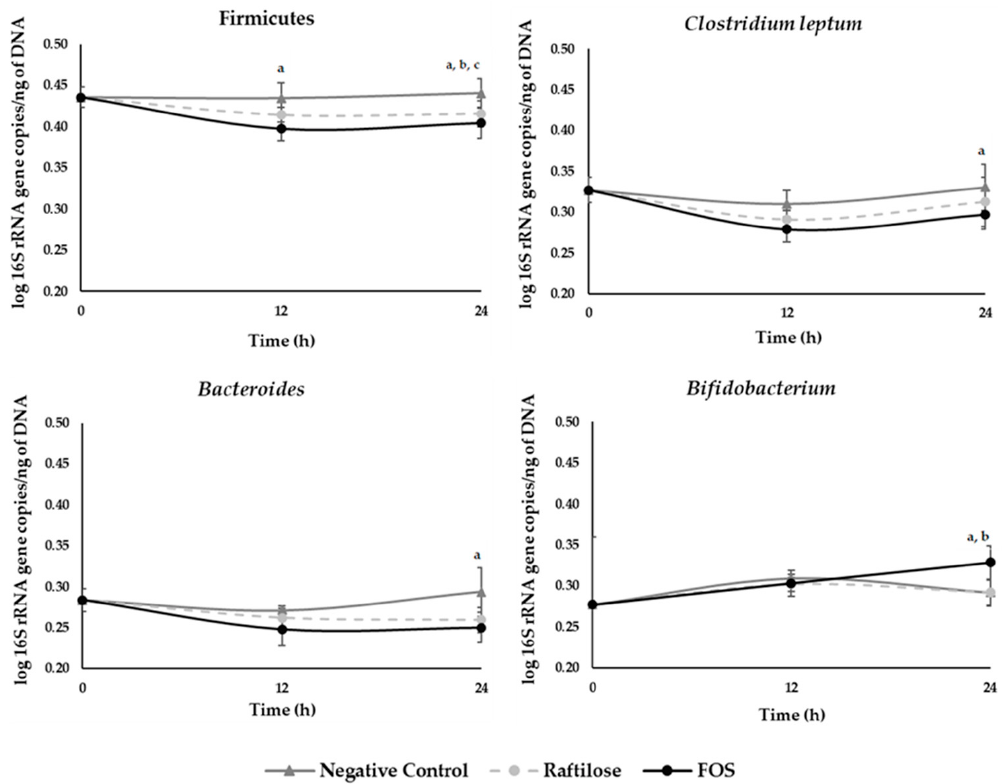
Figure 4. Variation of Firmicutes, Clostridium leptum , Bacteroides, and Bifidobacterium from five microbiota donors during fermentation with microbial-fructo-oligosaccharides (FOS), Raftilose ® P95 and without carbon source (negative control). Values are expressed as log 16S rRNA gene copies/ng of DNA through time (h), with standard deviation bars; a, b, c means statistically significant differences ( p < 0.05) between: a—microbial-FOS and negative control, b—microbial-FOS and Raftilose ® P95, c—Raftilose ® P95 and negative control.